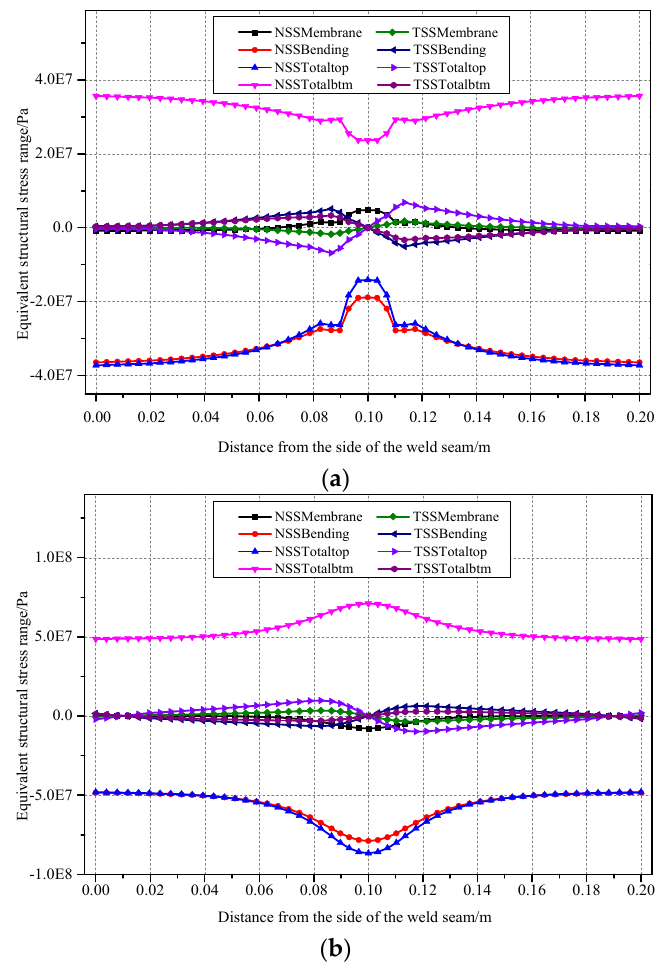
Figure 12. Equivalent structural stress of the weld root and weld toe of the weld seam of a large root. ( a ) Equivalent structural stress of Large-Weldline1, ( b ) equivalent structural stress of Large-